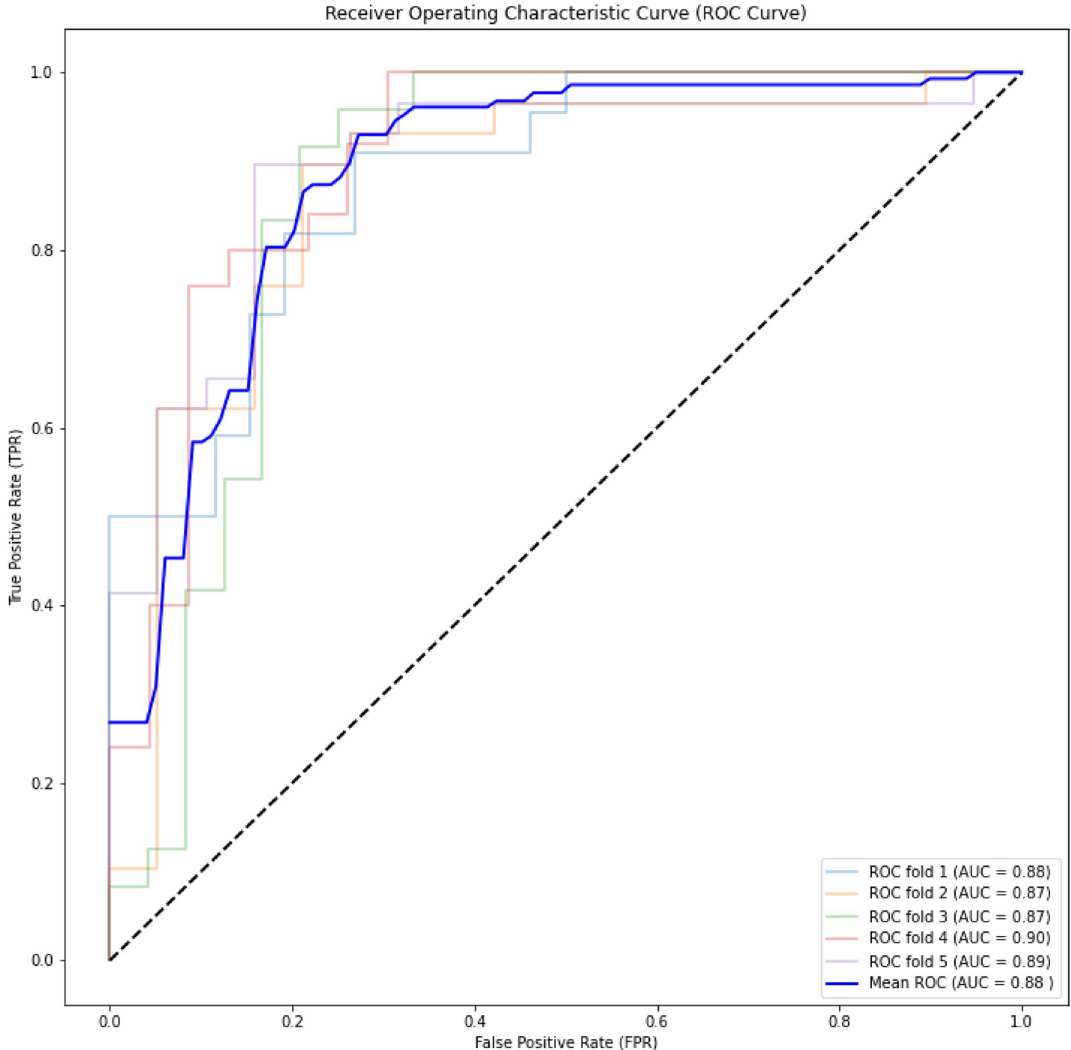
Figure 2. ROC curve for ACP-740 dataset for the fivefold cross-validation on the experiment. As shown in these figures, we constantly achieve very high Area Under the Curve (AUC)